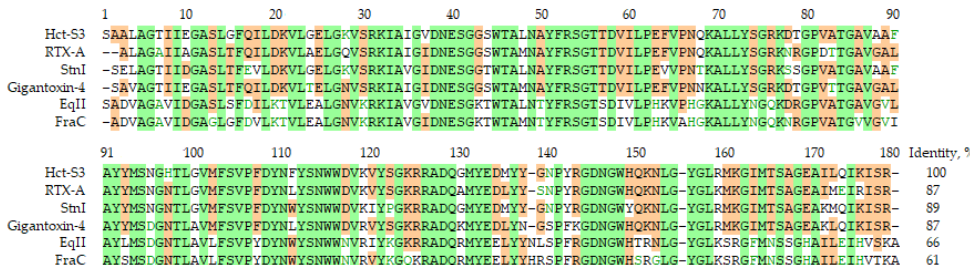
Figure 5. Multiple sequence alignment of actinoporins. EqII (P61914) from Actinia equina , FraC (B9W5G6) from Actinia fragacea , Gigantoxin-4 (H9CNF5) from Stichodactyla gigantea , StnI (P81662) from Stichodactyla helianthus , and RTX-A (P58691) from Heteractis crispa . The identical and conservative amino acid residues are shown on green and brown background.